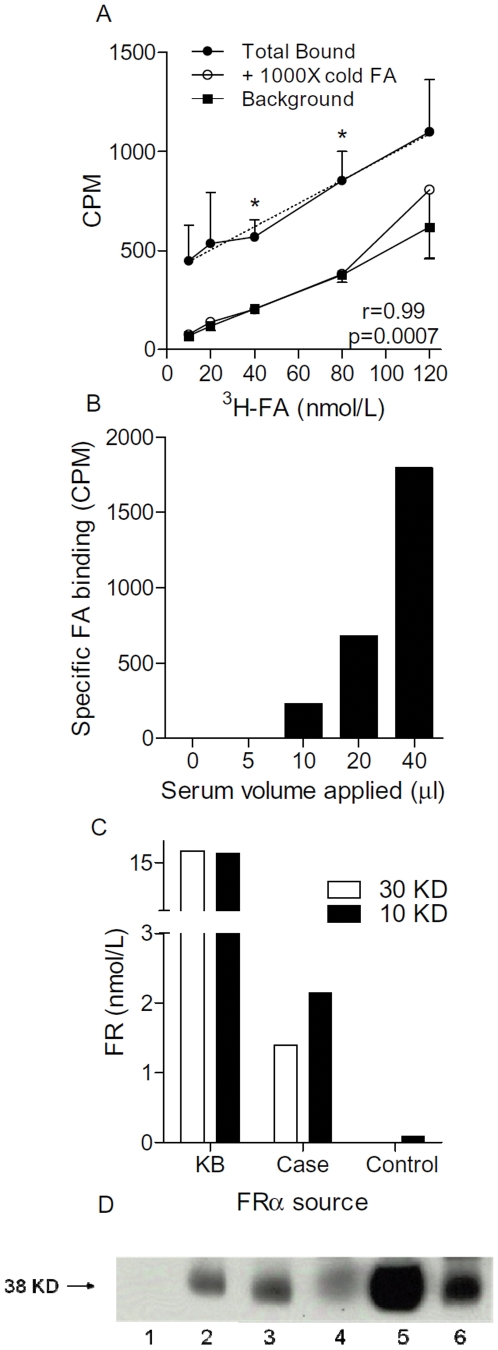
Detection of circulating FRα using microfiltration and immunoblotting.Panel A: Ten µl aliquots of KB culture supernatant was diluted to 50 µL with binding buffer that contained increasing concentrations of 3H-FA pulsed, without (Total bound) or with 1000X cold FA. After incubation, unbound FA was removed by microfiltration. Shown are the CPM retained by the microfilter. Also shown is Background which is binding in the absence of KB supernatants and without excess cold FA. *p<0.05. Each data point is the mean (±SE) of 3 replicates. The inset dotted line is the linear regression line of the total bound presented with the corresponding p and r values. Panel B shows that the amount of specific binding is dependent on the input levels. In this case increasing amounts of serum containing a KB protein spike were examined. This experiment is representative of 2 different experiments. Panel C shows the FA concentration that was bound in either KB supernatants or a representative serum sample from a case and control, comparing the 30 KD and 10 cutoff microfilters. Experiment is representative of two experiments. Panel D shows a representative example of immunoblot analysis of FRα. Arrow = Mr 38000 protein; KD = kilodalton; IP = immunoprecipitation. Lane 1, IP w no serum; lane 2, IP of KB lysate; lane 3, IP of precleared serum with KB lysate spike; lane 4. IP of serum alone, lane 5, KB lysate no IP; lane 6, IP of KB lysate no serum.